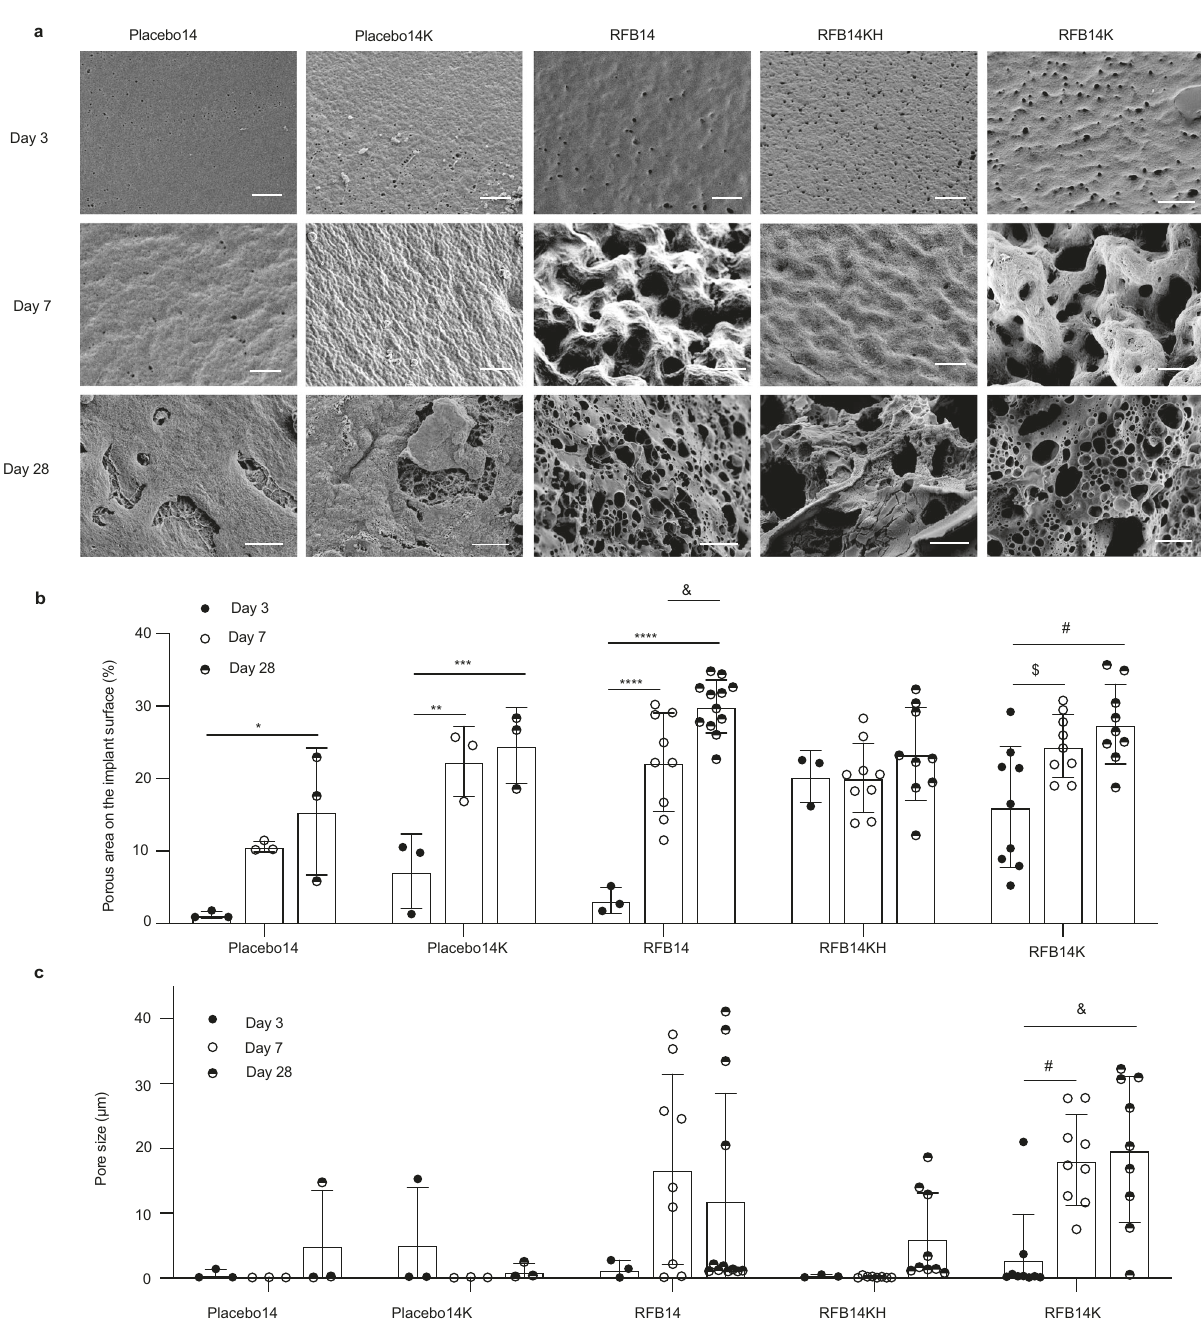
b , c Quantitative SEM analysis of implant surface images for changes in b porous area (* P =0.032, ** P =0.024, *** P =0.0136, **** P =0.0001, & P =0.056, $ P =0.0242, # P =0.0021) and c poresize ( # P =0.0027, & P =0.001) overtime. Data are presented as mean values +/ − SD. Source data for panels b and c are provided as a Source data fi